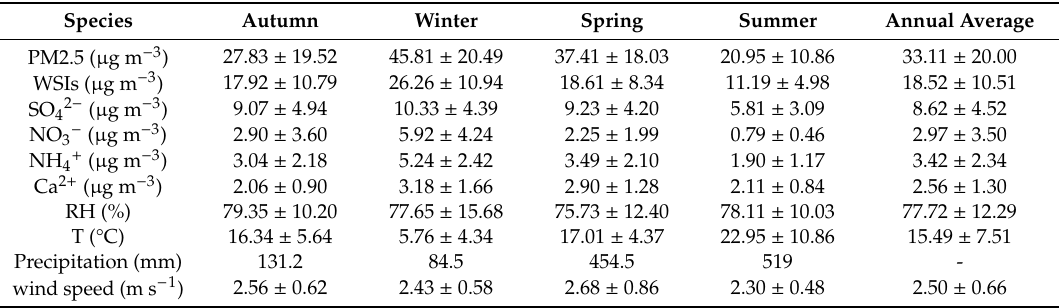
Table 1. The Seasonal and annual concentration of water-soluble ions and PM2.5 and meteorological parameters during sampling in Guiyang (Mean ± SD, except the precipitation) and the precipitation was the total values during each season.